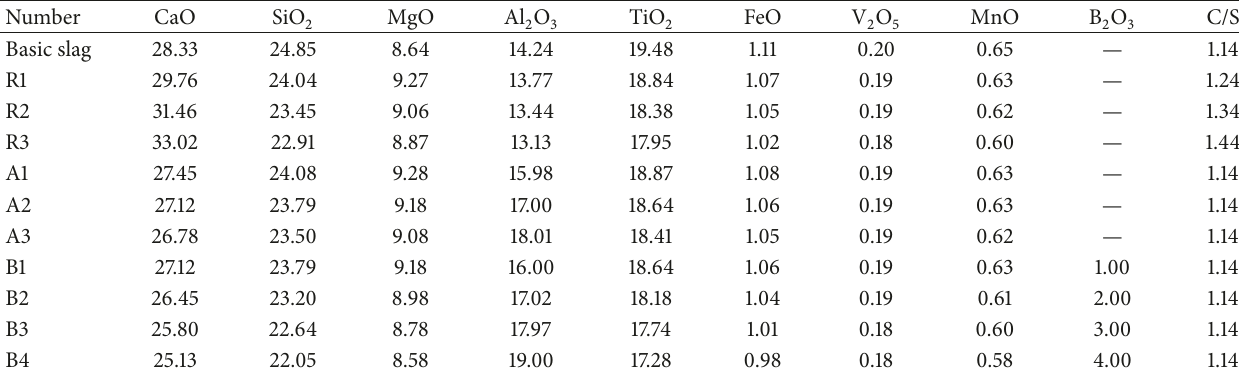
Table 1: Chemical compositions of slag samples (wt.%).